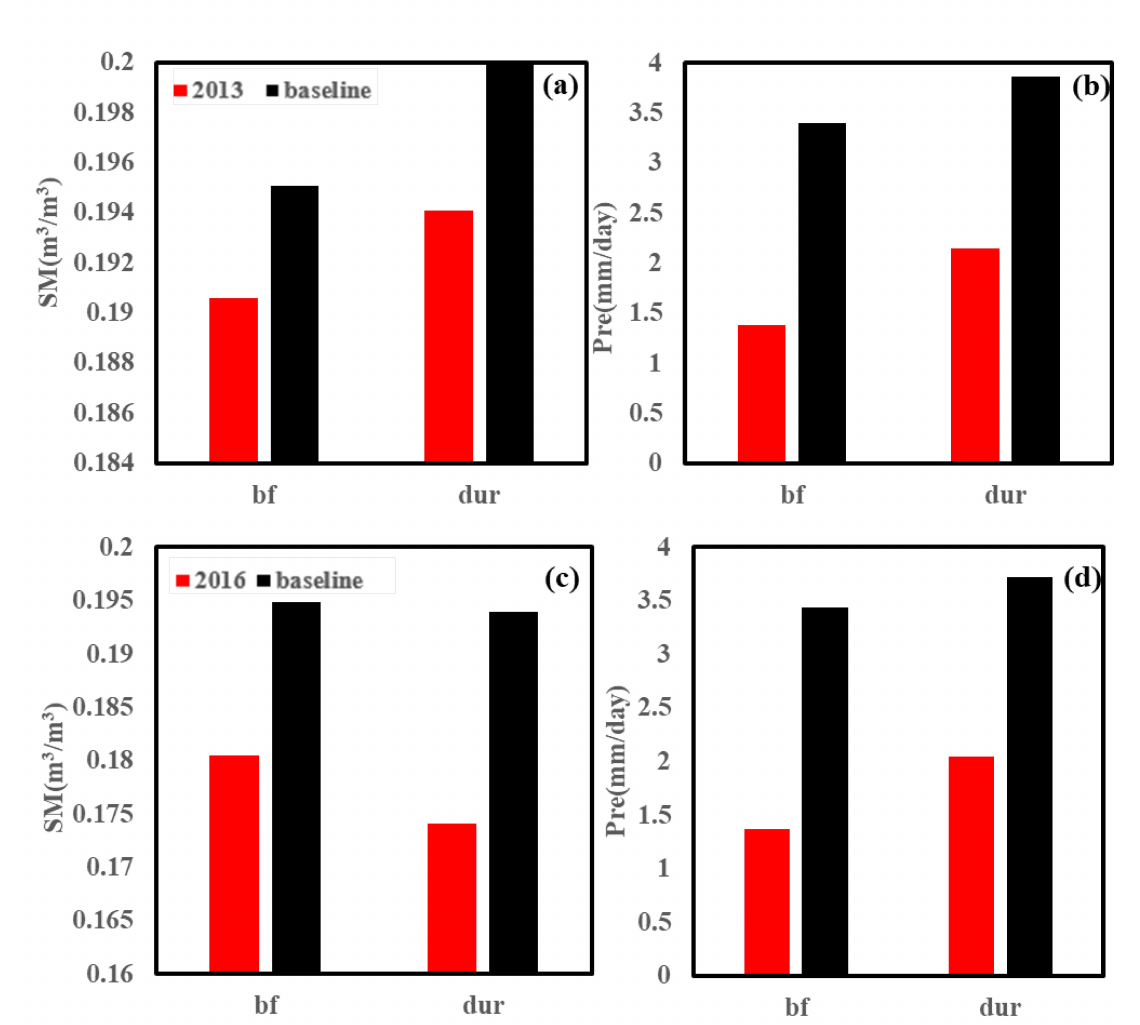
Figure 10. Precipitation and soil moisture comparison before and during the heatwave occurrence in June 2013 and August 2016. ( a , c ) represent the average soil moisture before/during two selected heatwave periods versus multi-year average soil moisture in the corresponding periods. ( b , d ) repre- sent the average daily precipitation before/during two selected heatwave periods versus multi-year average soil moisture in the corresponding periods. The red bars indicate the heatwave years. The black bars indicate the baseline period (soil moisture: 2002–2019, pre: 2000–2020). The “bf” represents the period before the heatwaves (9 June 2013–14 June 2013 DOY: 160–165 and 9 August 2016–15 August 2016 DOY: 221–227). The “dur” indicates the heatwave periods (15 June 2013–20 June 2013